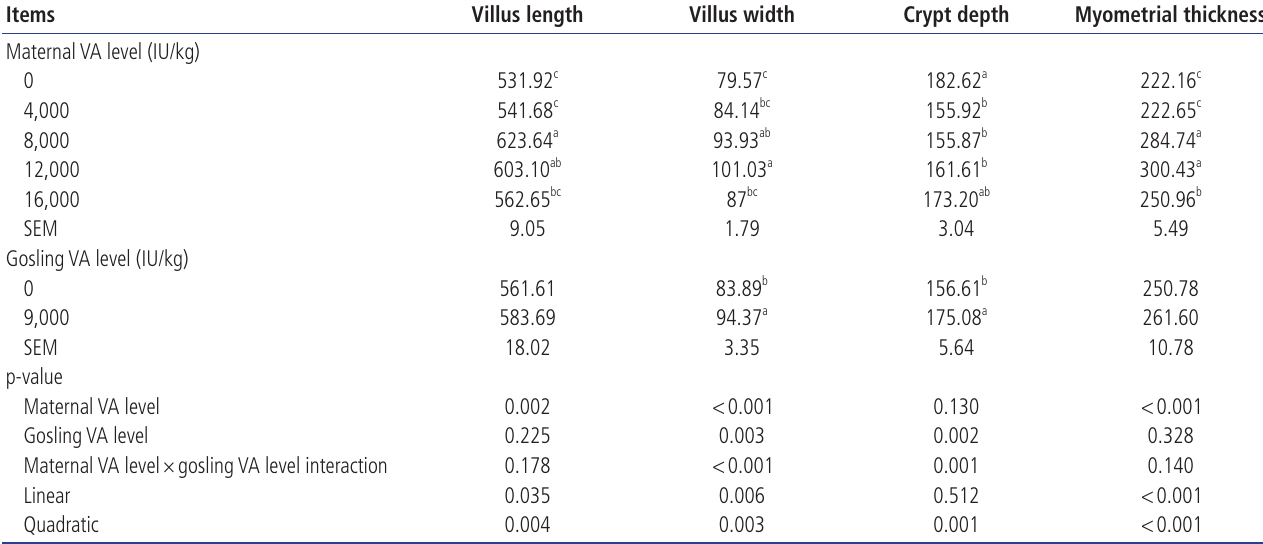
Table 4. Effects of different vitamin A levels in maternal and offspring diets on ileum histomorphology of goslings (μm) Items